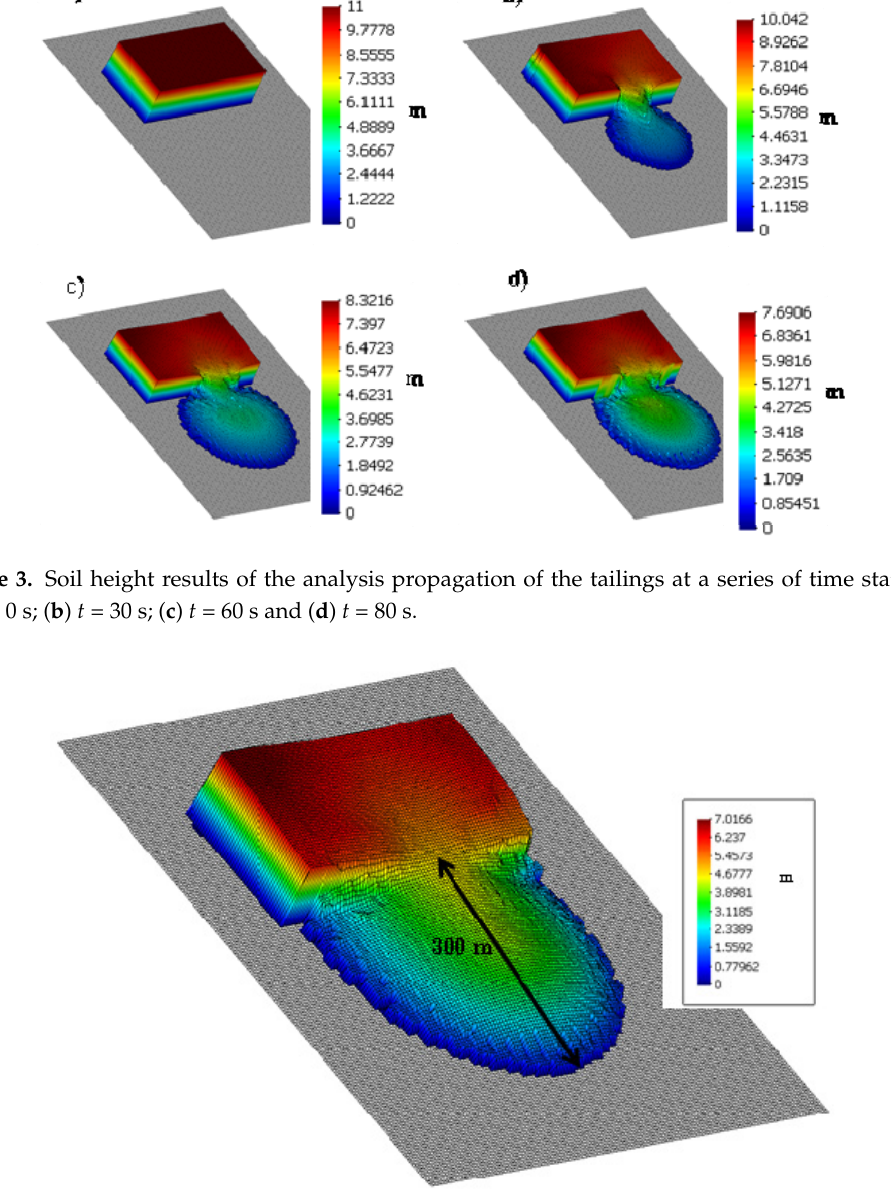
Figure 4. Soil height results of the analysis propagation of the tailings at t = 120 s with a final run out of 300 m.